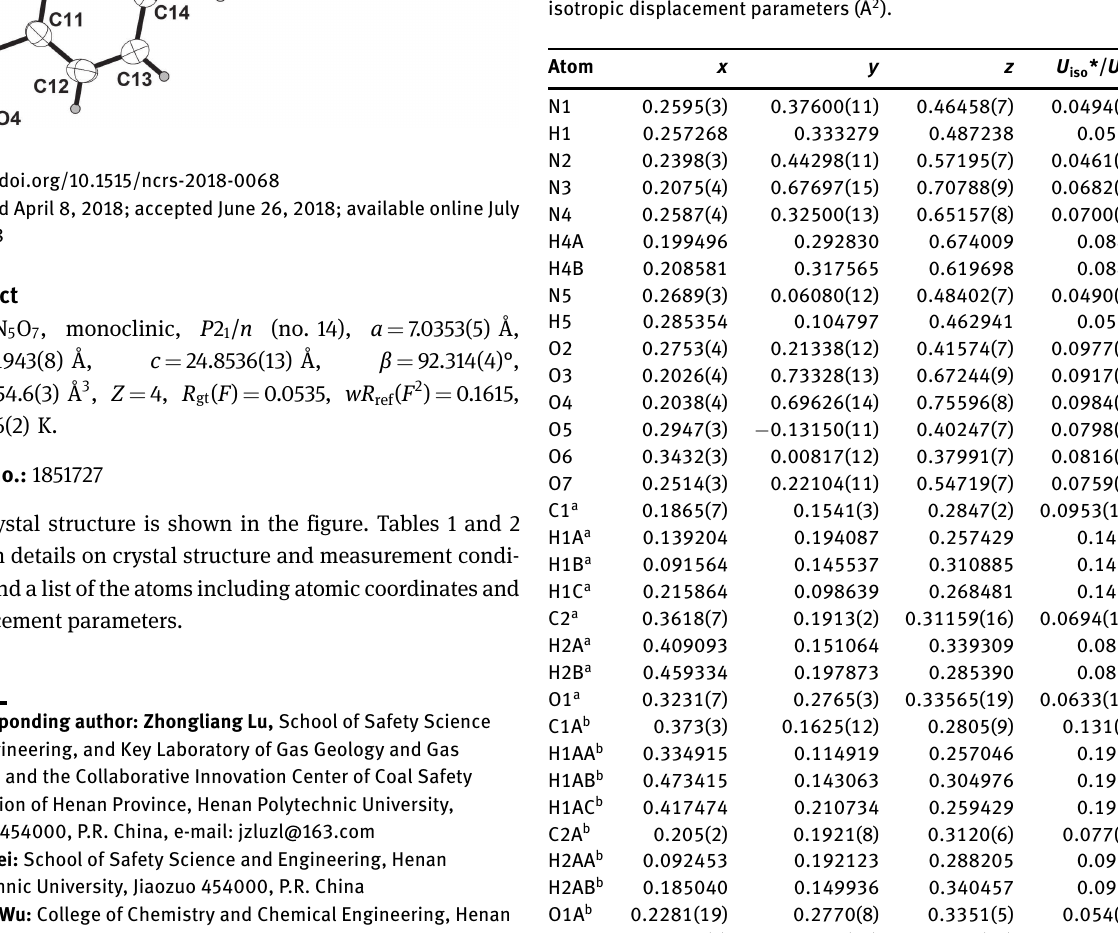
Table 2: Fractional atomic coordinates and isotropic or equivalent isotropic displacement parameters (Å 2